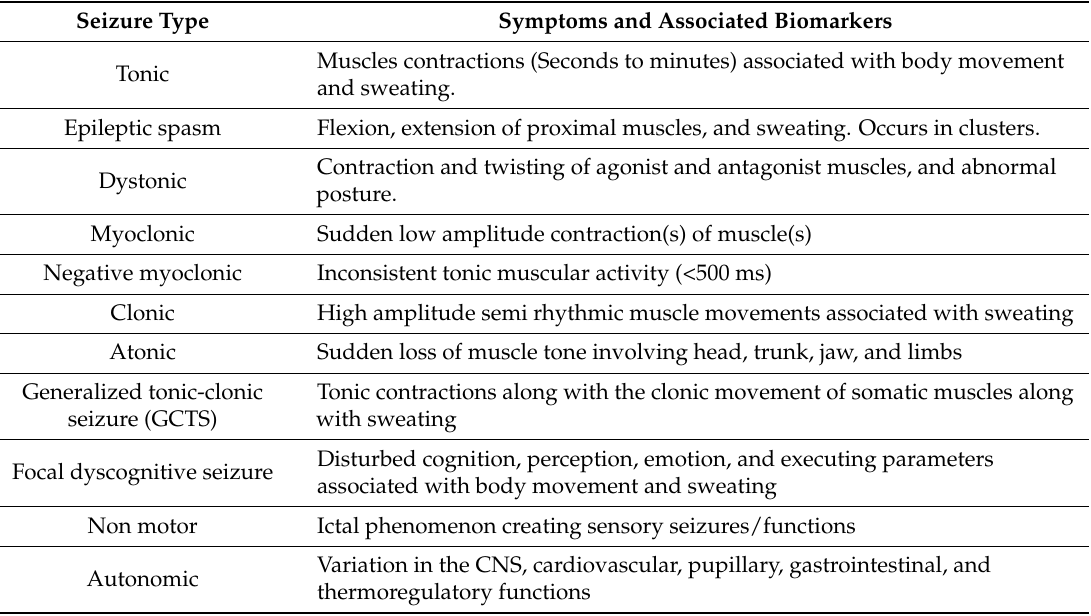
Table 1. Different types of seizures and related changes in